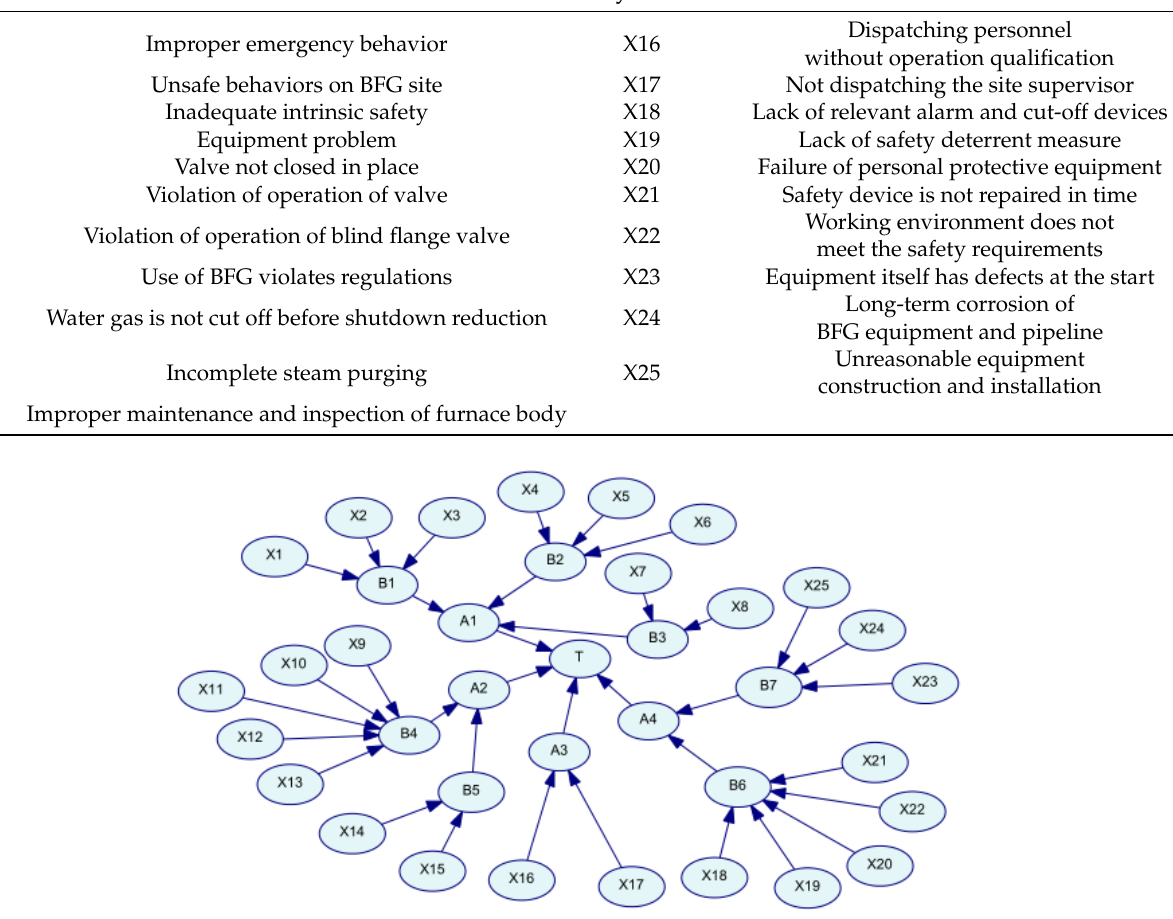
Figure 3. Directed acyclic graph of BFG leakage accidents.